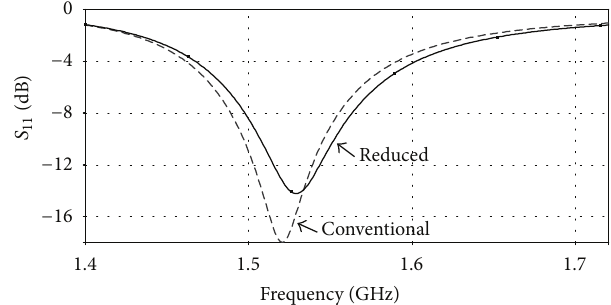
Figure 8: Comparison of simulated 𝑆 11 parameter of conventional and reduced IFA.